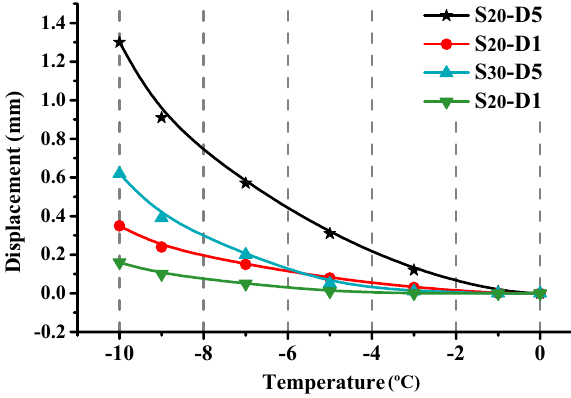
Figure 8. Displacement at 0–10 °C according to Roman’s frost-heaving model.